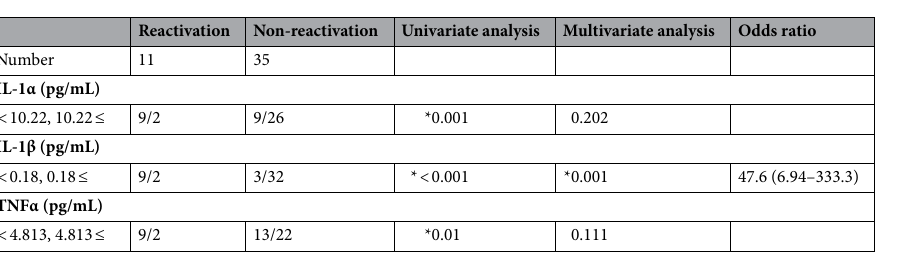
Table 2. Univariate and multivariate logistic regression analyses of cytokines significantly associated with HBV reactivation. HBV hepatitis B virus, IL interleukin, TNF tumor necrosis factor. *Statistically significant difference, P <